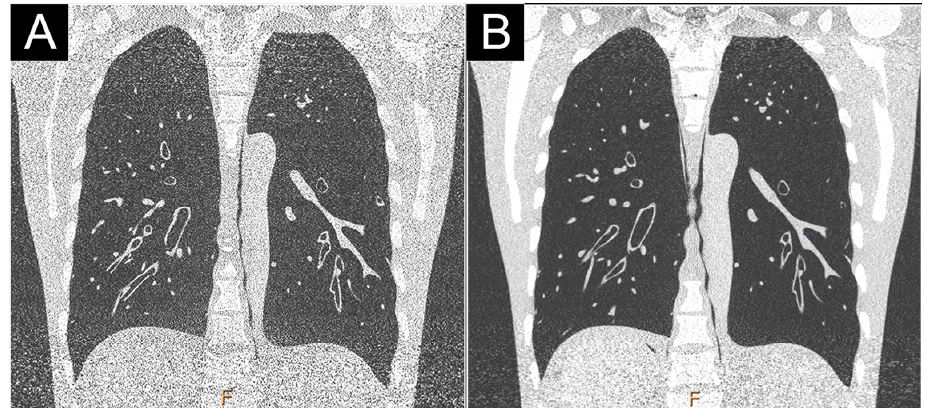
Figure 8. Comparison of high-resolution low dose lung imaging (120 kVp, 10 mAs) between a conventional dual-layer CT (iQon; Philips, Haifa, Israel; ( A ): filter YB) and a clinical PCD-CT (Philips; ( B ): filter detailed 1) in an anthropomorphic phantom CT Torso CTU-41 (Kyoto Kagaku, Tokyo, Japan). Both 1024 matrix and field-of-view of 350 mm were matched. Noise was significantly reduced on the PCD-CT images in the upper and basal lobes, greatly improving the image quality.